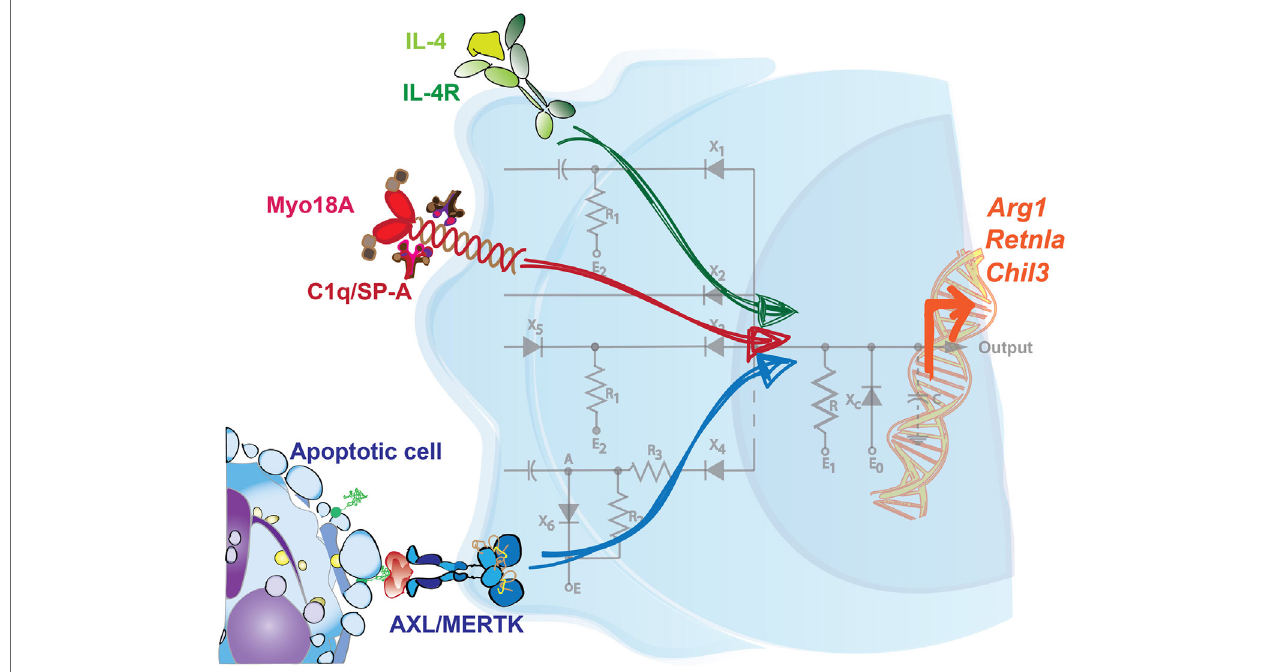
FiGURe 1 | Integration of signals is required to drive a specific tissue repair program in macrophages. Sensing of IL-4 in the presence of apoptotic cells promotes the expression of key tissue repair factors in macrophages. Neither signal on its own is sufficient to induce this genetic program, which includes the upregulation of Arg1 , Retnla , and Chil3 . Additionally, C1q and surfactant protein-A (SP-A) are each sensed through Myo18A in distinct macrophage populations, and in conjunction with IL-4, prompts a similar set of tissue repair genes. Mirroring the configuration of a circuit, multiple inputs are therefore necessary to coordinate a tailored output or response by